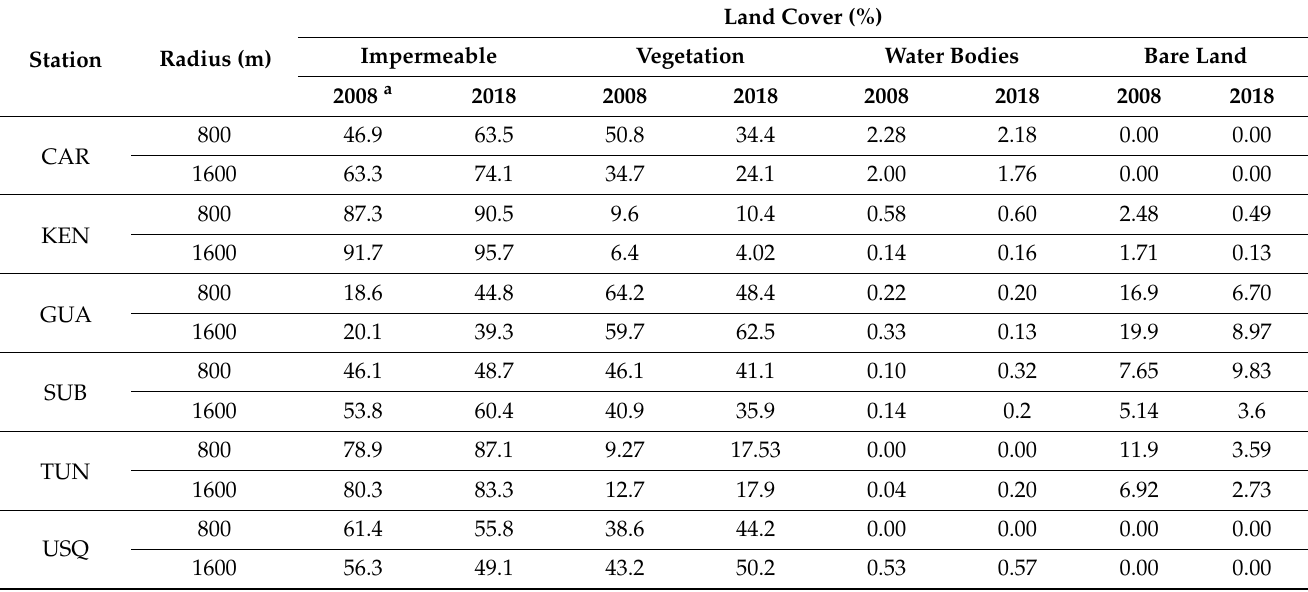
Table 2. Types of land cover associated with each monitoring